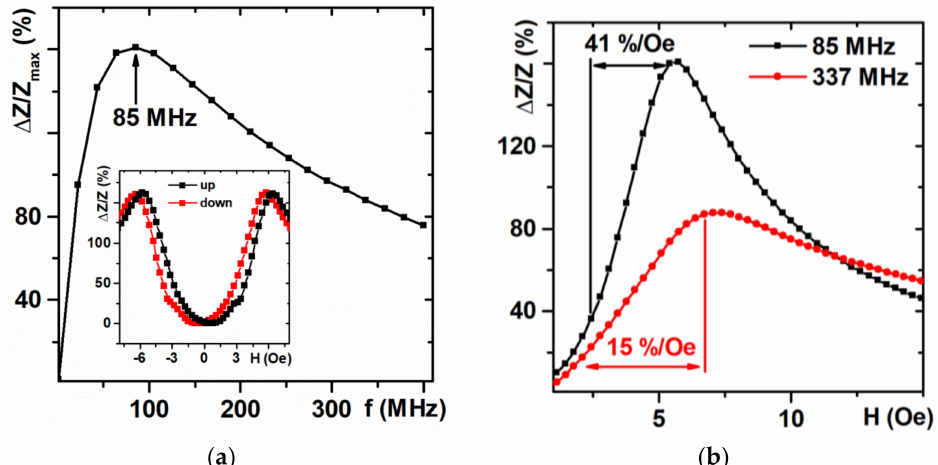
Figure 5. ( a ) Frequency dependence of the maximum value of the MI ratio. In the insert the field dependence of the MI ratio at 85 MHz high-frequency current. ( b ) “Down” curves of field dependence of the MI ratio at 85 and 337 MHz of the driving current